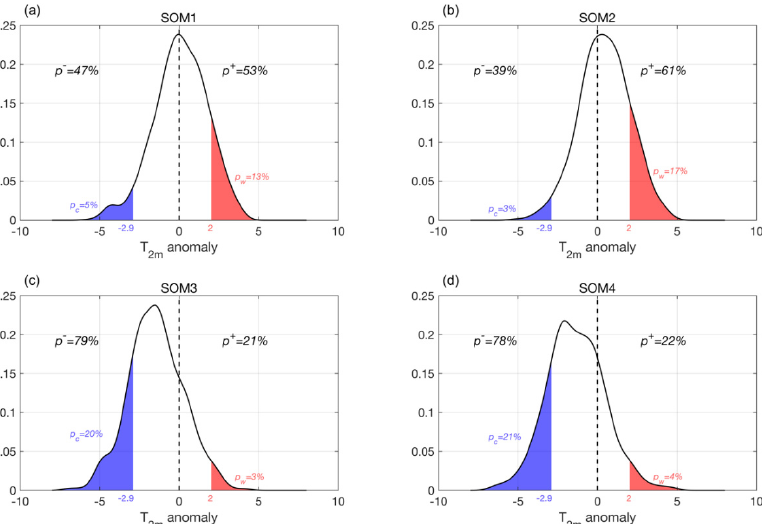
Figure 10. The probability density distribution is fitted by the daily T 2m anomalies of SOM1 ( a ), SOM2 ( b ), SOM3 ( c ), SOM4 ( d ). In each plot, the percentages p − and p + are the occurrence probabilities of cooling and warming days for each SOM group, respectively. The shaded areas are the probabilities of cold (blue) and warm (red) extremes, defined by 10% and 90% quantiles of the daily T 2m anomalies, respectively. J. Mar. Sci. Eng. 2022 , 10 , 1103